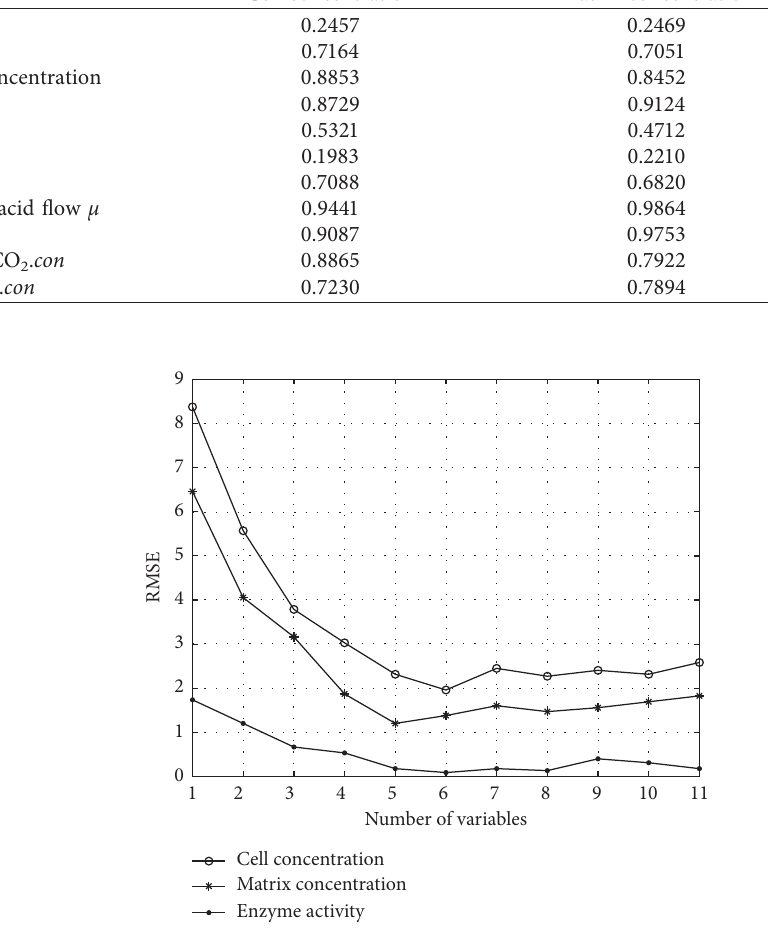
Figure 4: The influence of the number of variables selected by SPA algorithm.